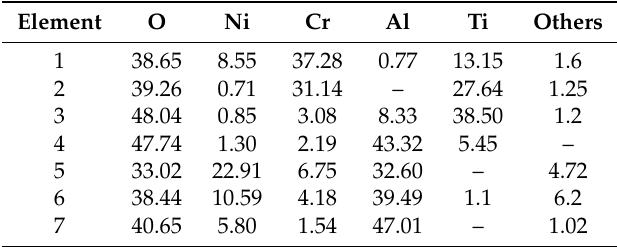
Figure 4. Surface morphologies after oxidation at 1050 °C in air: ( A ) K38 superalloy oxidized in air for 100 h; ( B ) SN-K38 nanocrystalline coating oxidized in air for 100 h; ( C ) SN-N5 nanocrystalline coatings after oxidized in air for 20 h and ( D ) 100 h. Table 4. Chemical composition (wt.%) measured at surface of N5 nanocrystalline coating (denoted in Figure 4) by EDS.